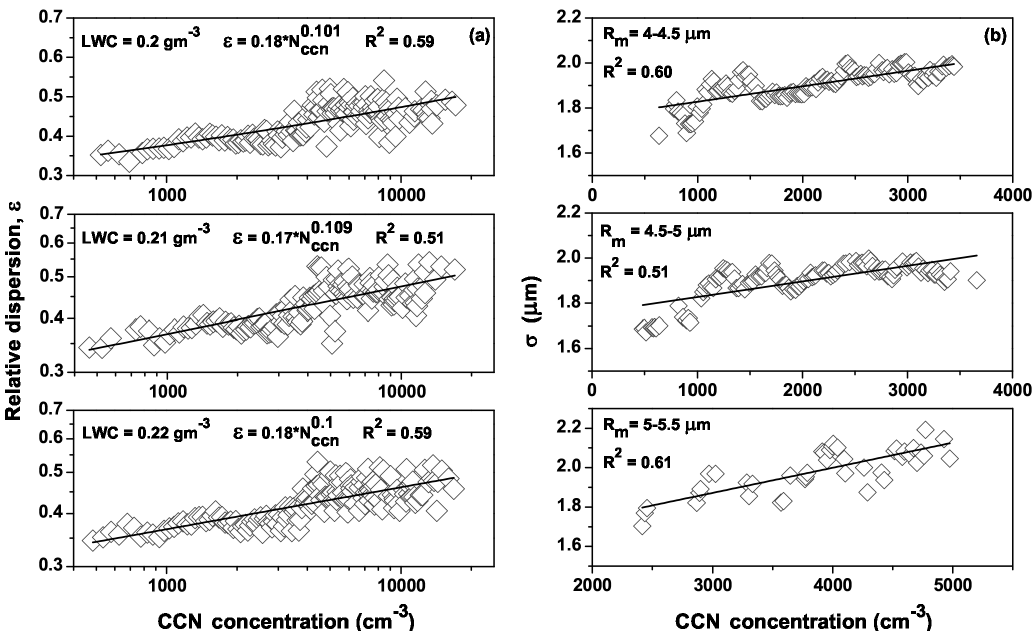
Figure 6. Scatter plots showing the changes in relative dispersion ( ε) and spectral width of cloud droplet ( σ) with CCN number concentration.